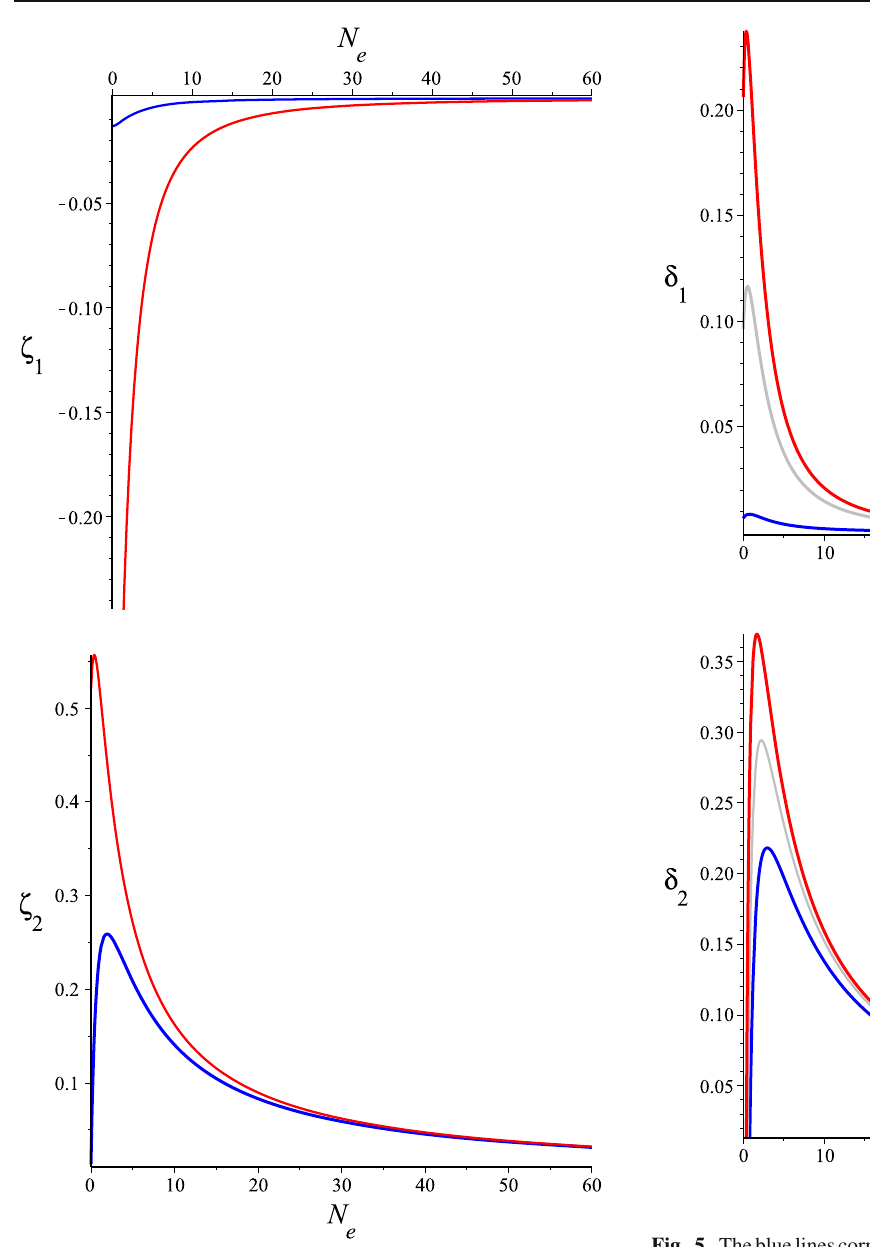
Fig. 4 The parameters ζ 1 and ζ 2 as functions of N e . The blue lines correspond to f 0 = 0 . 1, the red lines correspond to f 0 = 8